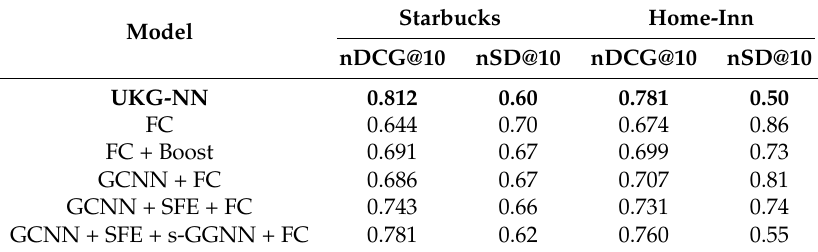
Table 8. Ablation study for optimal store placement.